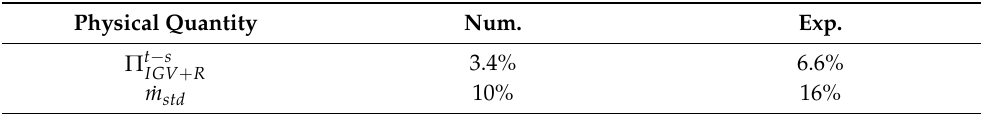
Table 3. Comparison of performance fluctuation amplitude at OP2 between experimental and numerical data.